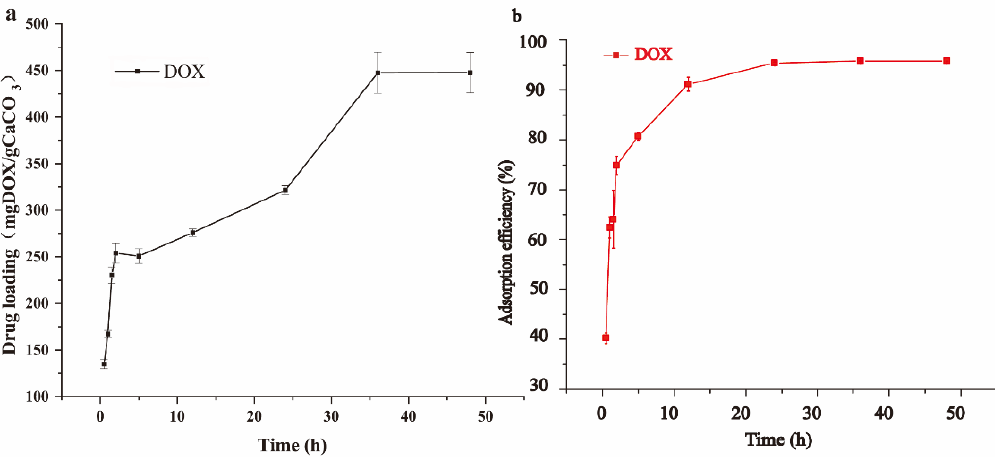
Figure 6. Effect of different times on DOX adsorption. ( a ) Drug loading. ( b ) Efficiency of drug encapsulation.